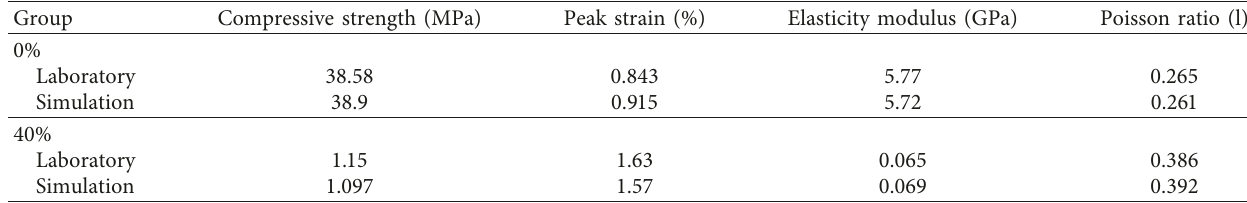
Figure 8: The calibration curve of constitutive relation of materials. (a) NC, 0% rubber. (b) CRC, 40% rubber. Table 2: Mechanical parameters and PFC